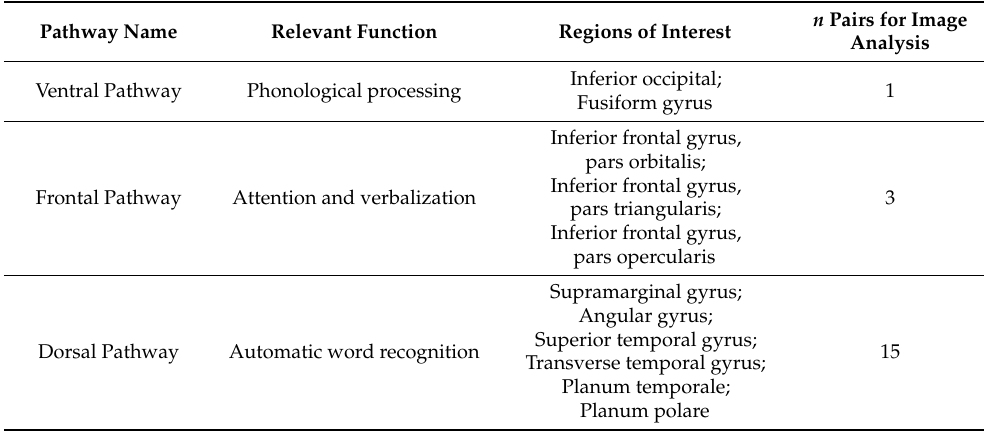
Table 1. Regions of interest (ROIs) used for imaging